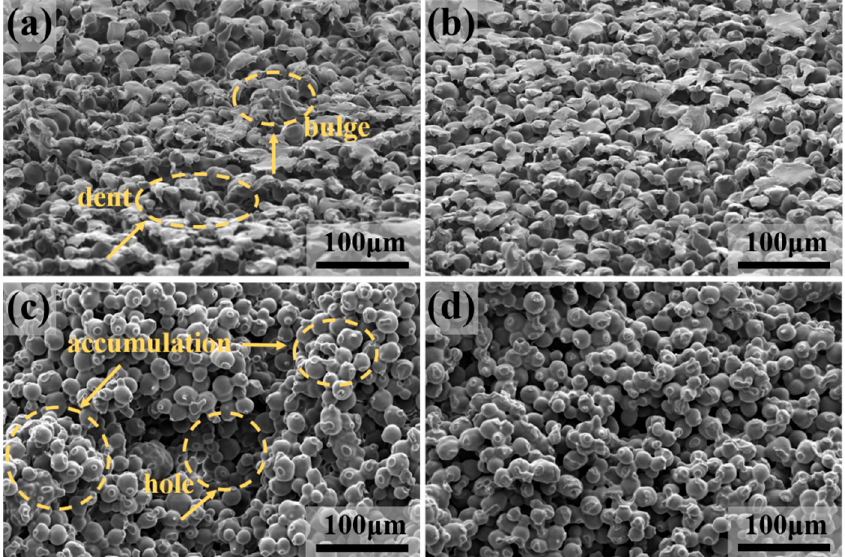
Figure 4. Microstructure of the sample under different forming states: ( a , b ) Surface microstructure of the sample under the molding condition of static sintering and rotary sintering, respectively. Arrows in ( c ) indicate the bulges and dents in the surface; ( c , d ) cross-sectional microstructure of sample under the molding condition of static sintering and rotary sintering. Arrows in ( c ) indicate the closely packed and large holes of the porous microstructure.